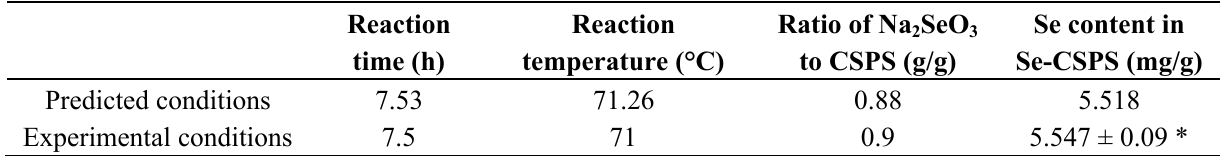
Table 4. Predicted and experimental values of the responses under optimum